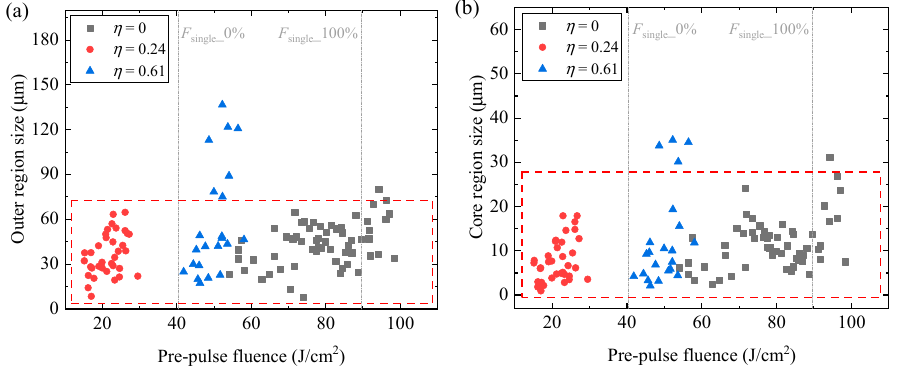
Figure 6. Size distributions of ( a ) the outer and ( b ) core regions of the damage sites on main-pulse fluence for η = − 0.78, η = 0 (single-pulse), η = 0.24 and η = 0.61.